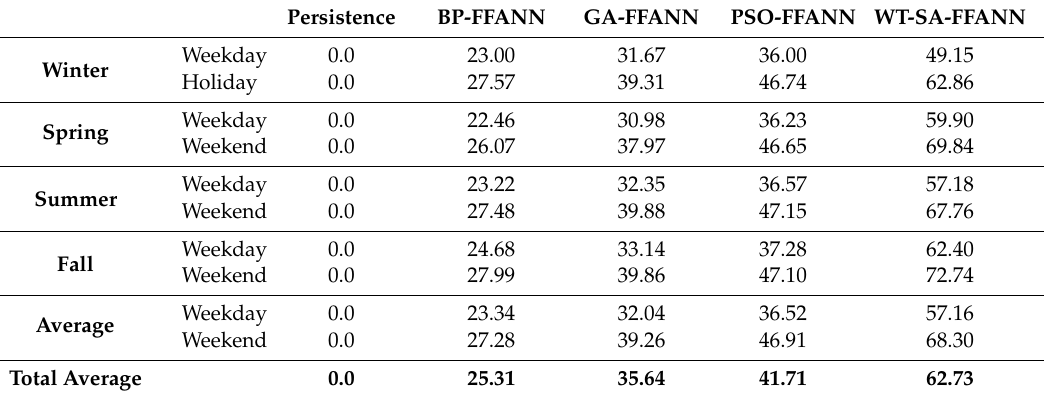
Table 7. Comparative Forecast Skill